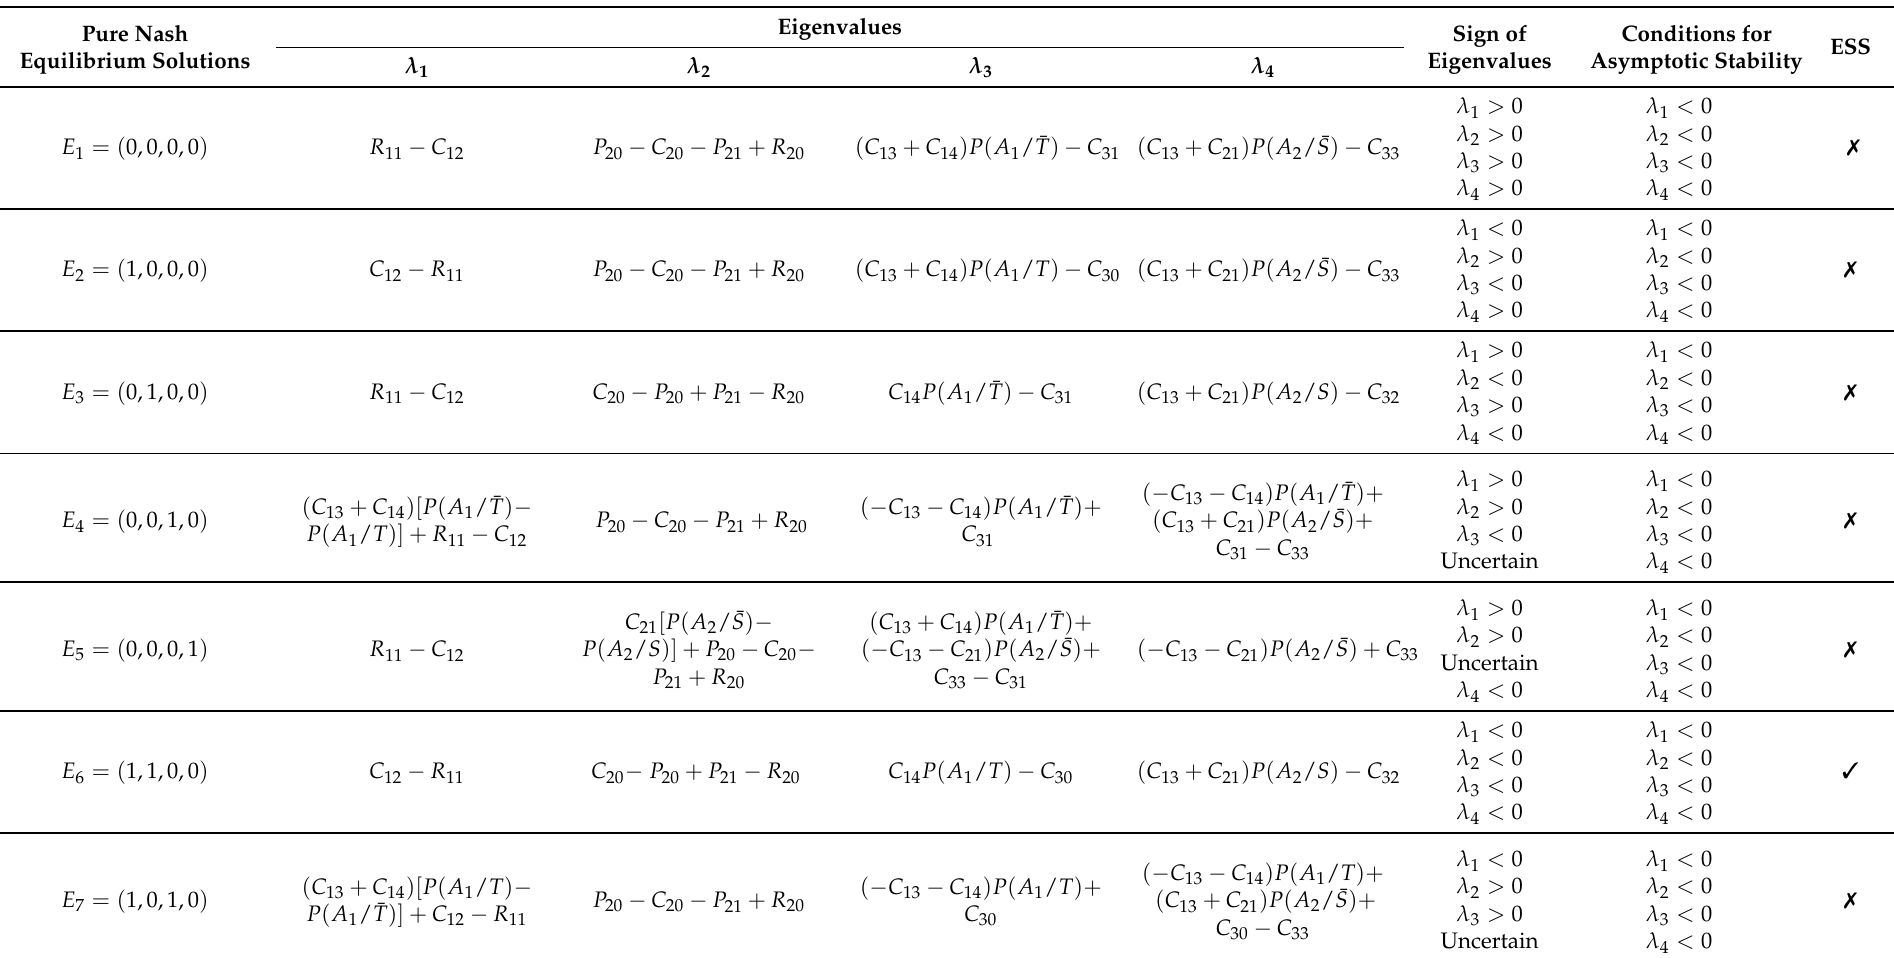
Table 4. Summary of equilibrium stability